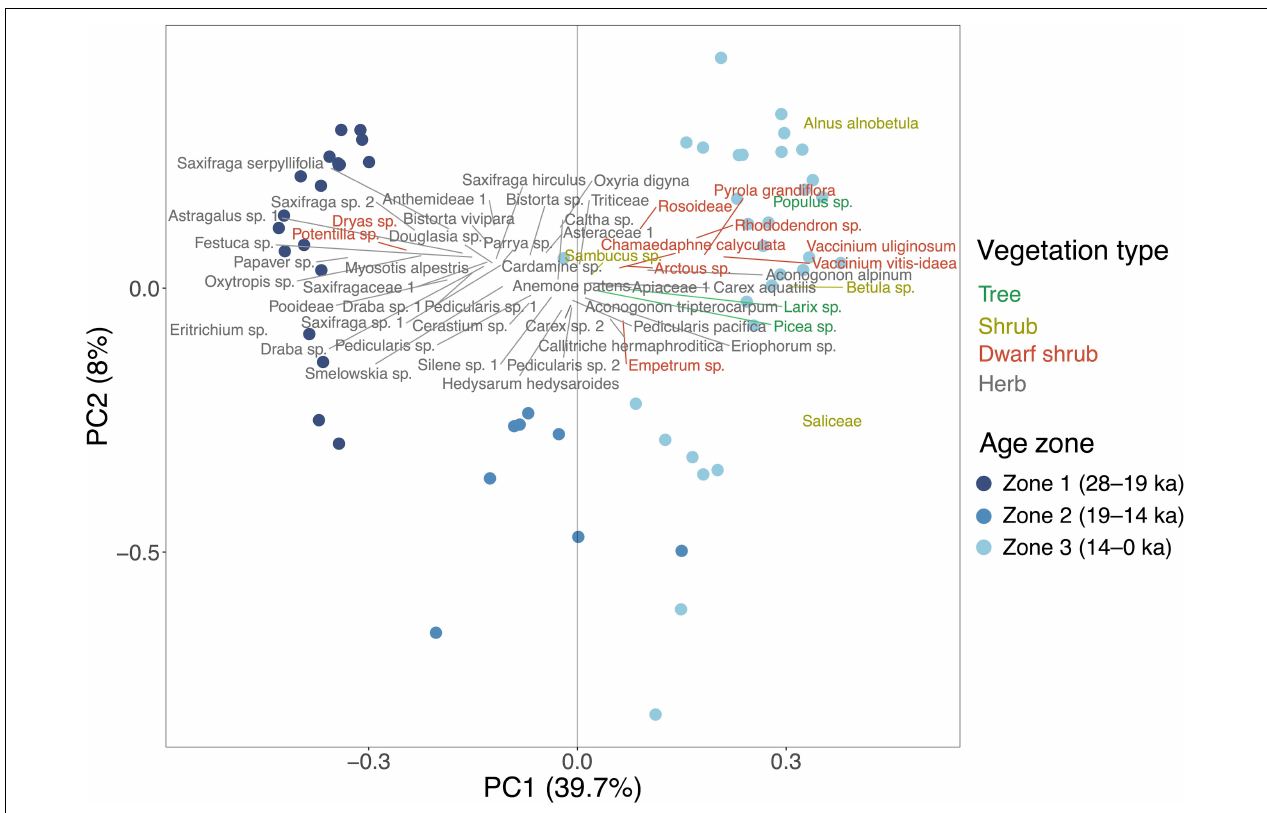
FIGURE 3 | Principal component analysis (PCA) biplot of plant taxa from sedimentary ancient DNA, showing a subset of the dominant taxa (maximum relative abundance > 20% and occurrence > 3) which explain most of the variance in the dataset. Sample ages are color-graded based on zones, which are estimated by a depth-constrained CONISS cluster analysis.